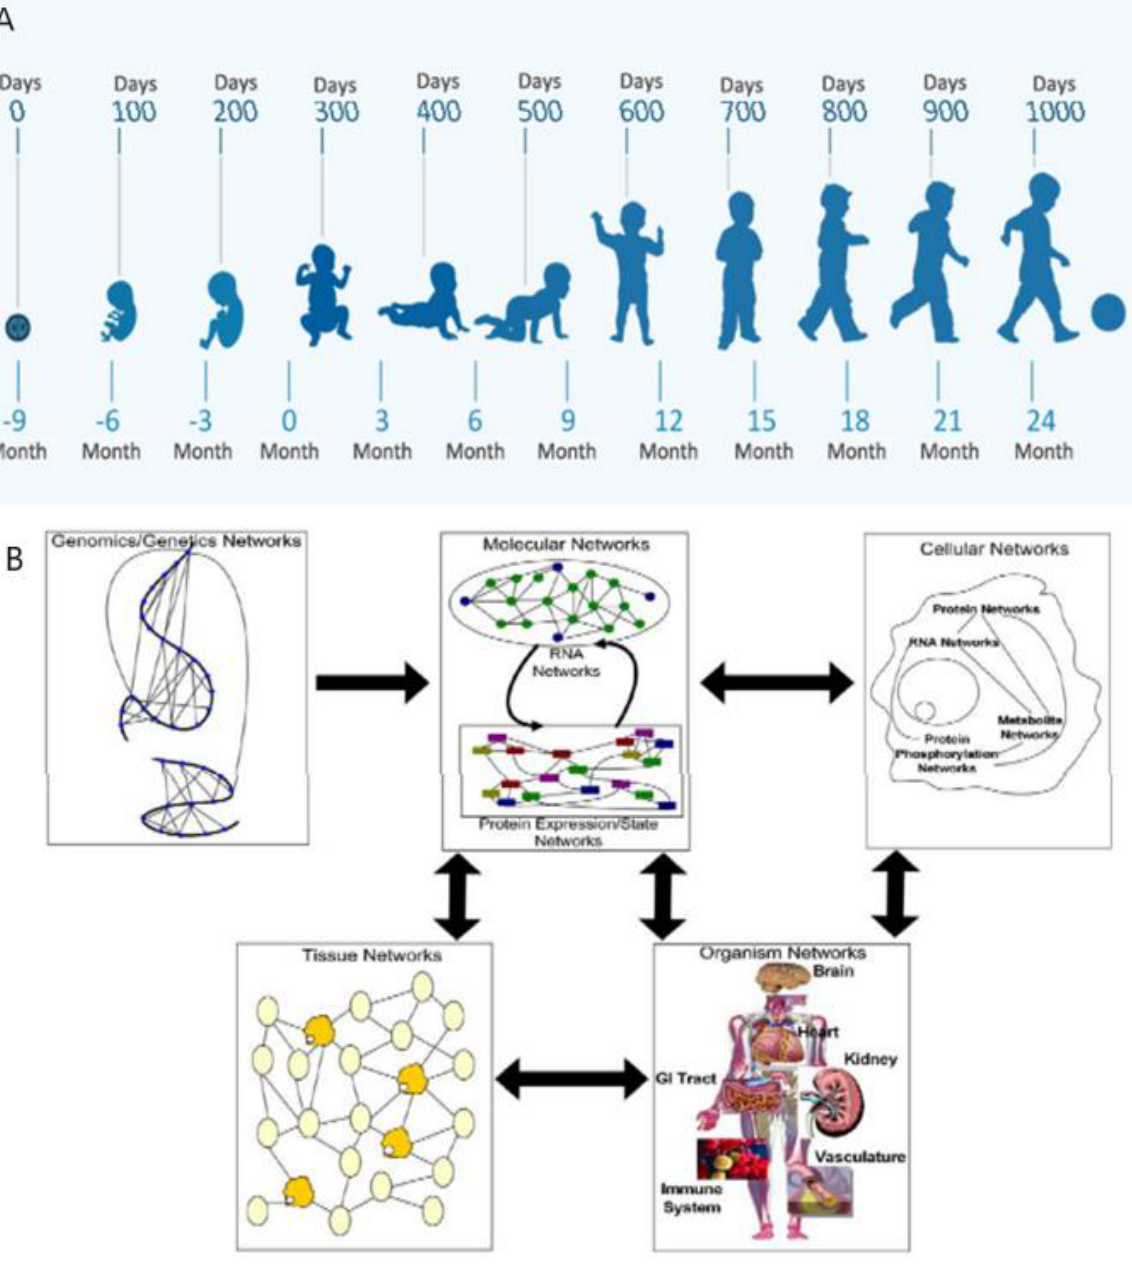
Figure 1. ( A ) The horizontal approach to the diagnostic process across maturing phenotypes over the first 1000 days. The WHO program diagram depicts the first 1000 days from conception through two years of age that illustrates changing clinical expressions. ( B ) The vertical approach to the diagnostic process depicted as the flow of information across biological systems through a hierarchy of networks. Each panel highlights a different set of networks at play in a biological system.